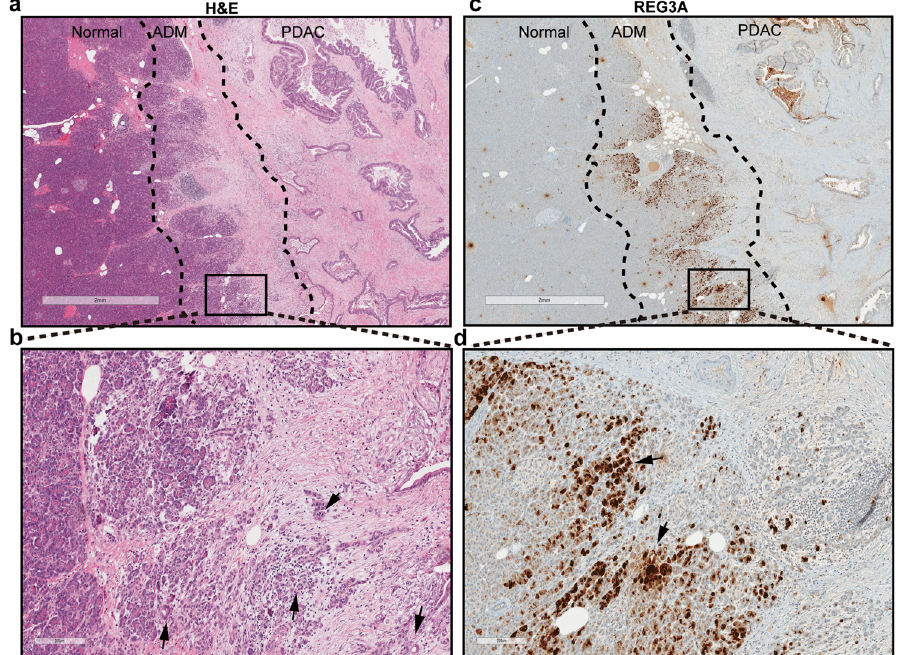
Fig. 1 REG3A is overexpressed in the ADM area adjacent to human PDAC. a H&E staining shows histological evidence of transformation from normal acini to ADM and to PDAC. Magni fi cation, ×10; Scale bar: 2 mm. b Enlarged view of ADM area in a . Magni fi cation, ×100; Scale bar: 200 μ m. Black arrows indicate typical ADM circular structures. c Single antibody immunohistochemical staining shows intense REG3A expression the ADM zone. Magni fi cation, ×10; Scale bar: 2 mm. d Enlarged view of ADM area in c . Black arrows indicate typical ADM stained strongly with REG3A. Magni fi cation, ×100; Scale bar: 200 μ